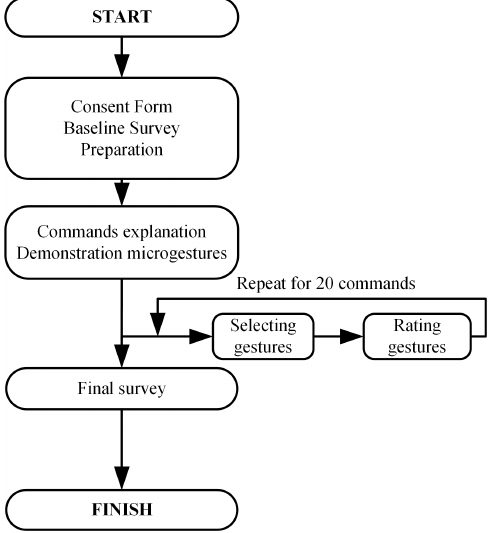
Figure 4. Flowchart of the experimental